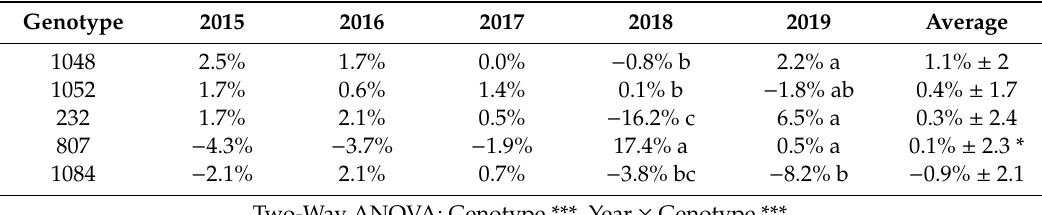
Table 5. Variation in percentage respect to predicted value per genotype and year in La Grajera field. Genotype